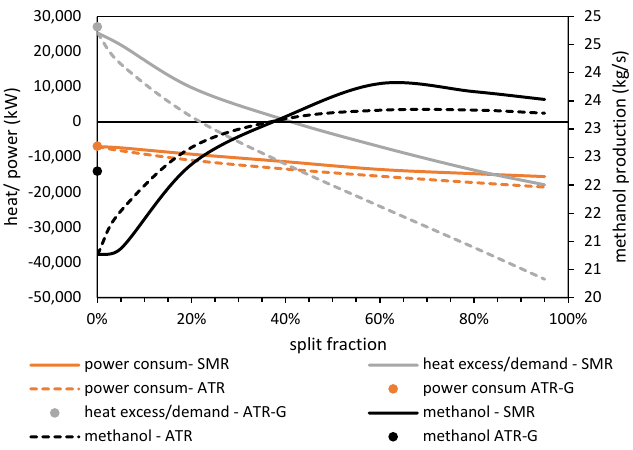
Figure 11. Impact of reformer type and portion of recycling gas that is reformed on the process performance (dots represent the respective values for the case of positioning an ATR after gasifier (ATR-G)).